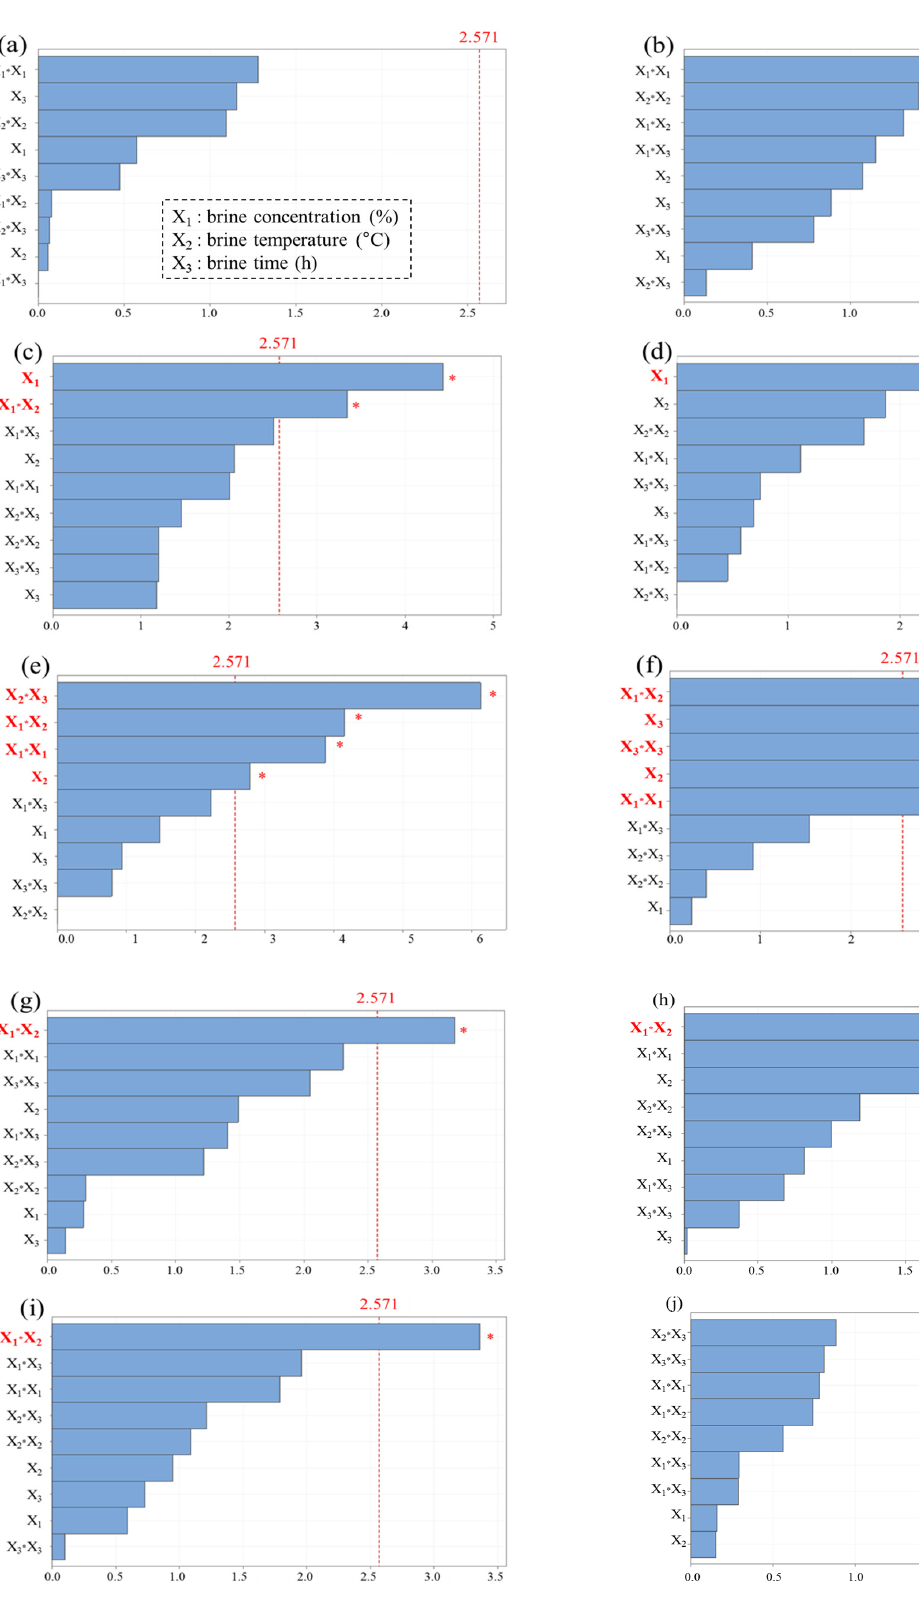
Figure 1. Pareto analysis of the efficacies of significant factors affecting the quality values on brined cabbage with statistical significance ( p < 0.05). ( a ) pH, ( b ) titratable acidity, ( c ) soluble solid contents, ( d ) salinity, ( e ) salt gain, ( f ) water loss, ( g ) weight reduction, ( h ) fructose, ( i ) glucose, ( j ) lactic acid bacteria.